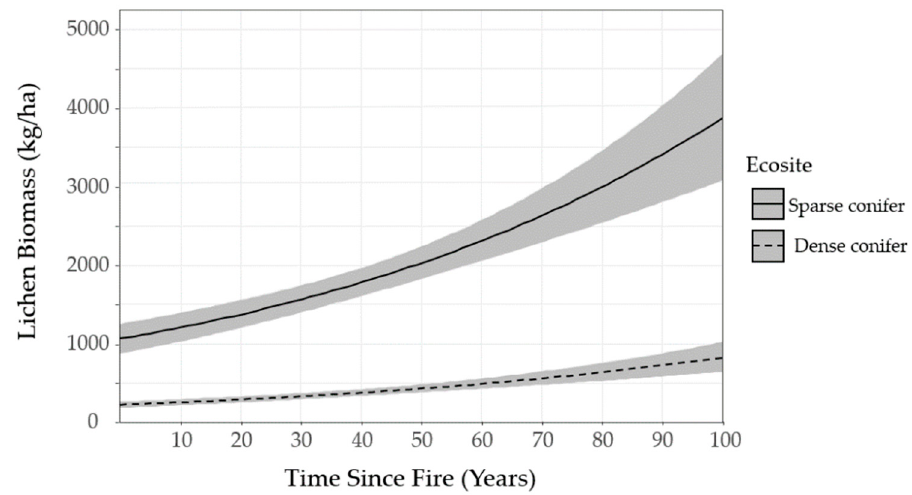
Figure 6. Lichen biomass (kg/ha) in sparse conifer and dense conifer ecosites as time-since-fire increases. Simulated from the top lichen abundance model for Woodland Caribou Provincial Park, Ontario, Canada. The dark lines represent the average trendline for each ecosite and the grey banners represent standard errors.